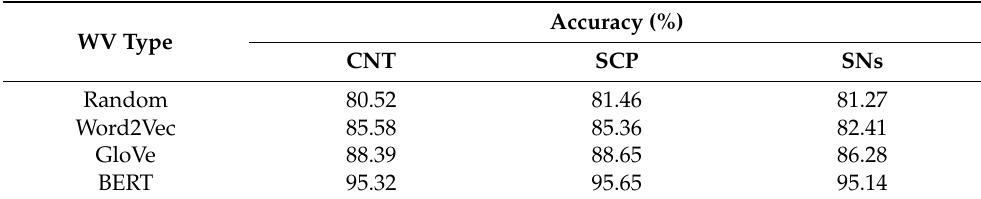
Table 3. TC accuracies obtained using different